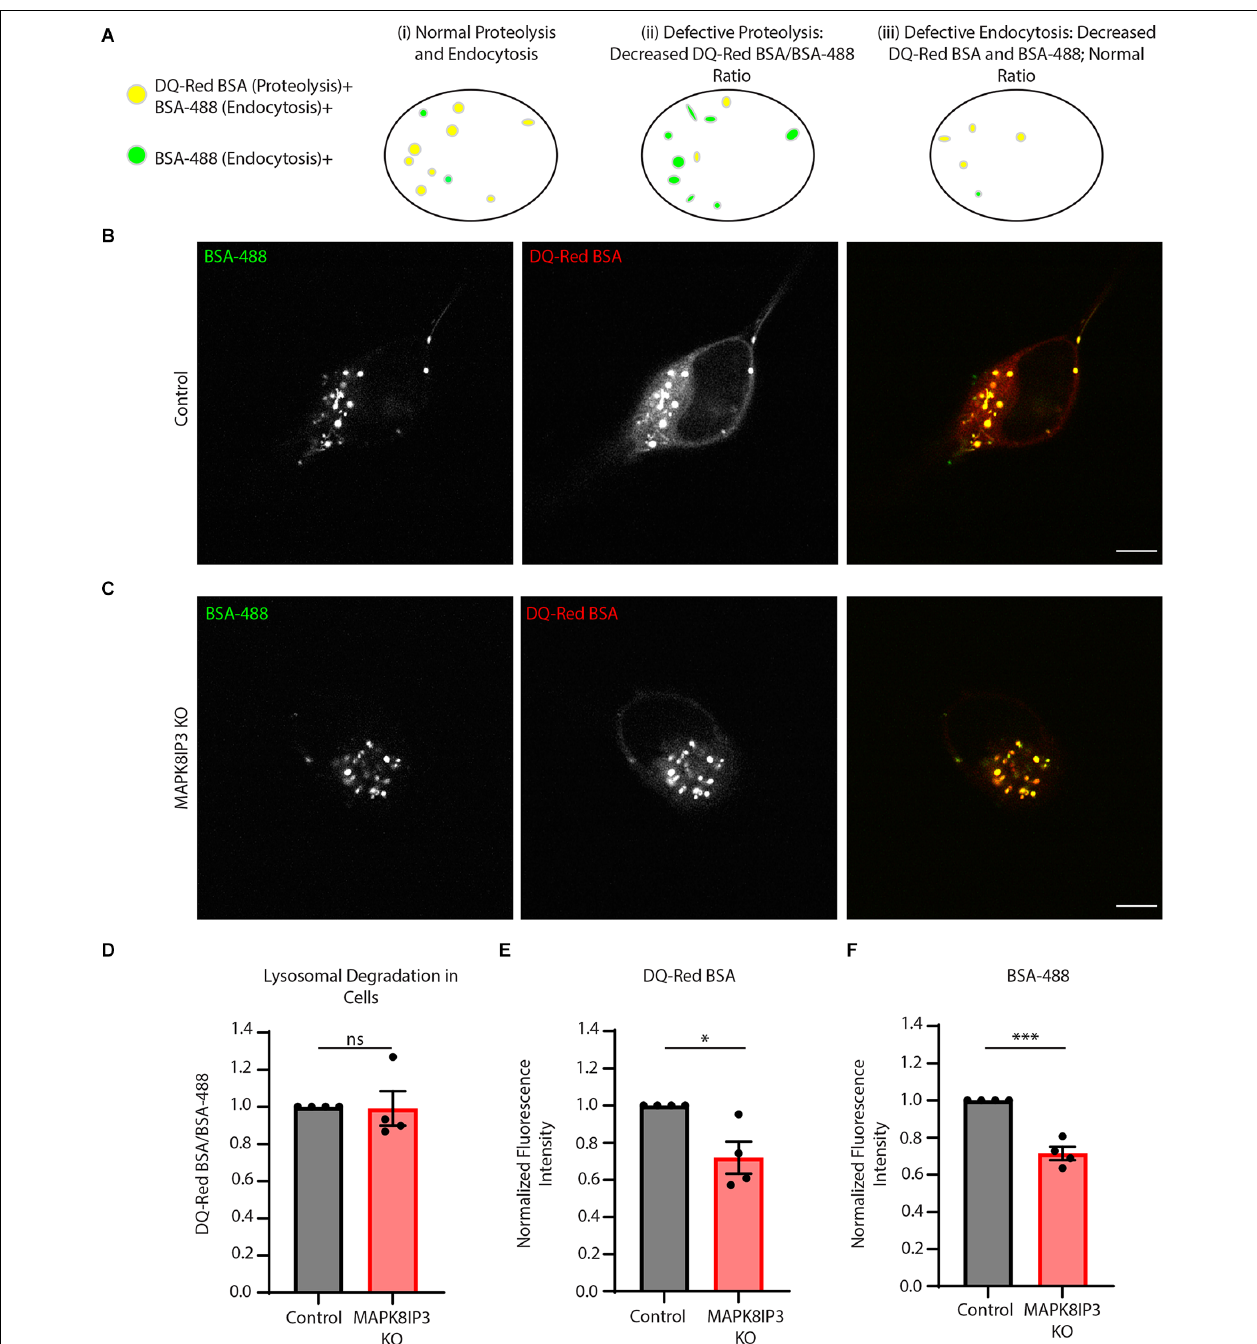
FIGURE 1 | MAPK8IP3 I 3 Neurons show reduced endocytic uptake of BSA. (A) Schematic showing that proteolytically active lysosomes are positive for both DQ-Red BSA and BSA-488, shown in yellow, and BSA-488 positive endosomes shown in green (i). If lysosomal proteolysis is perturbed (ii), there will be a decrease in the ratio of DQ-Red BSA fluorescence intensity/BSA-488 fluorescence intensity (as both probes are taken up but due to lack of optimal proteolysis, there is reduced DQ-Red BSA fluorescence signal). Lastly, if there is reduced endocytic uptake of both probes, the ratio of DQ-Red BSA fluorescence intensity/BSA-488 fluorescence intensity appears comparable to that of normal cells (indicating normal lysosomal proteolysis) but overall intensity of each of those probes is lower than normal cells (iii). (B,C) Representative images of Control and MAPK8IP3 KO i 3 Neurons at DIV14 after 5–7-h incubation with both probes. Scale bar: 5 µ m. (D) Quantification showing the normalized mean DQ-Red BSA/BSA-488 ratio in Control and MAPK8IP3 KO i 3 Neurons from four independent experiments. (E) Quantification of DQ-Red BSA fluorescence intensity in Control and MAPK8IP3 KO i 3 Neurons. (F) Quantification of BSA-488 fluorescence intensity in Control and MAPK8IP3 KO i 3 Neurons. (D–F) Quantifications represent mean ± SEM across four independent experiments (* P < 0.05, *** P < 0.001; ns, not significant; unpaired t -test). Control = 85 cells; MAPK8IP3 KO = 96 cells.